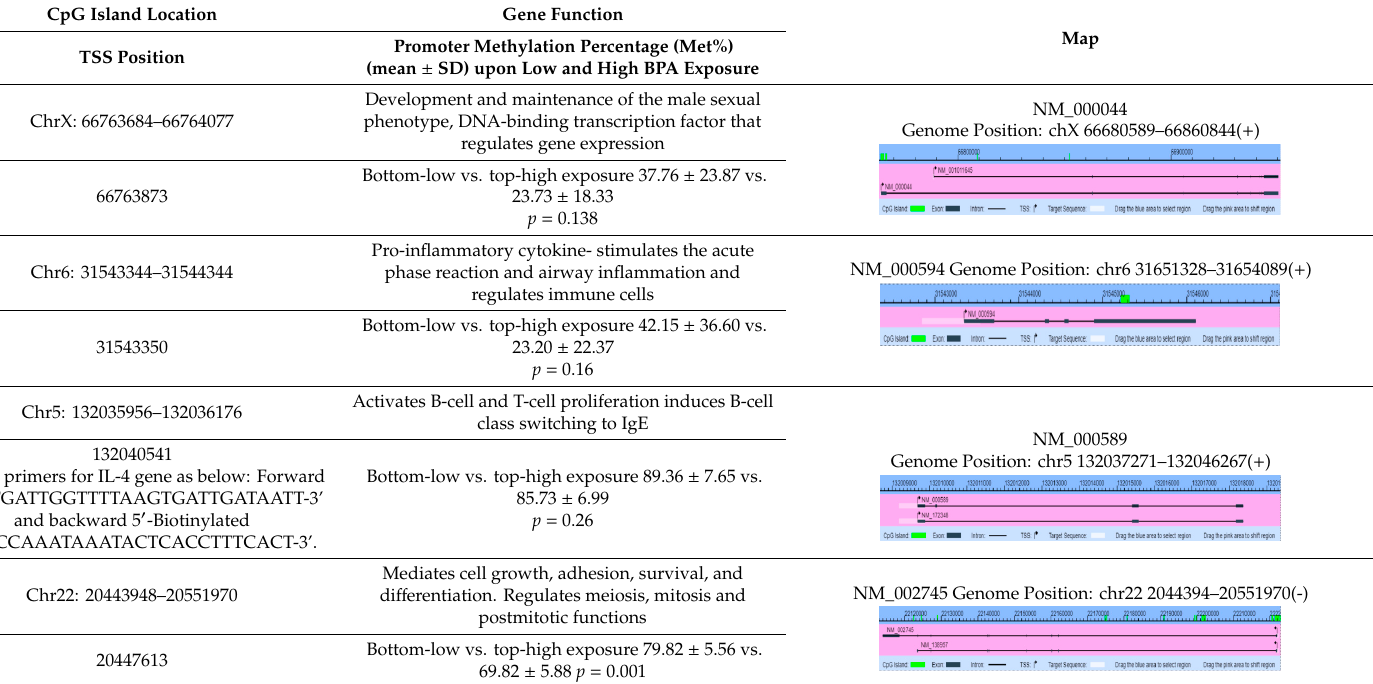
Figure source: MethPrimer